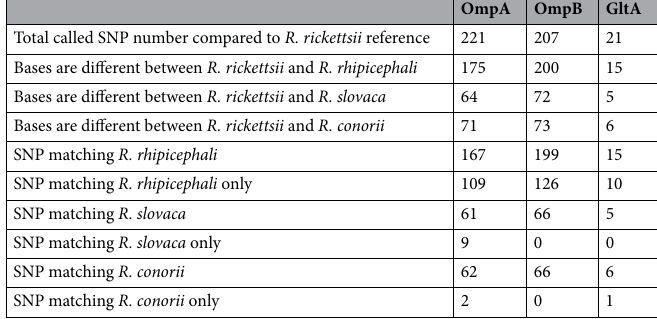
Table 3. Results of SNP analysis at OmpA, OmpB, and GltA gene